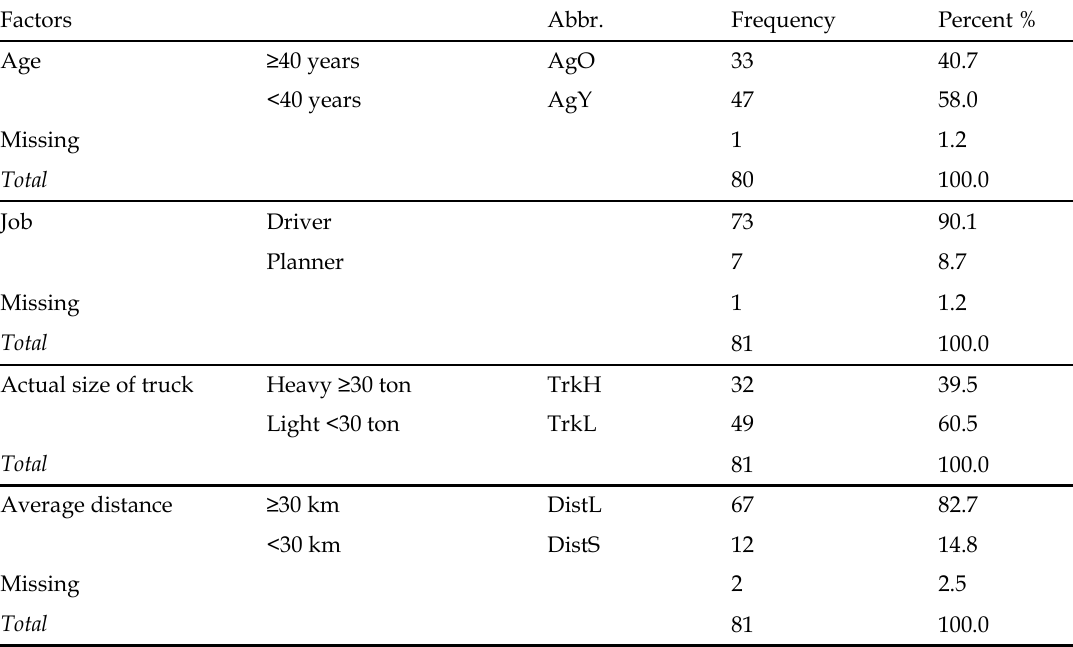
Table 2 Descriptive statistics on main concomitant